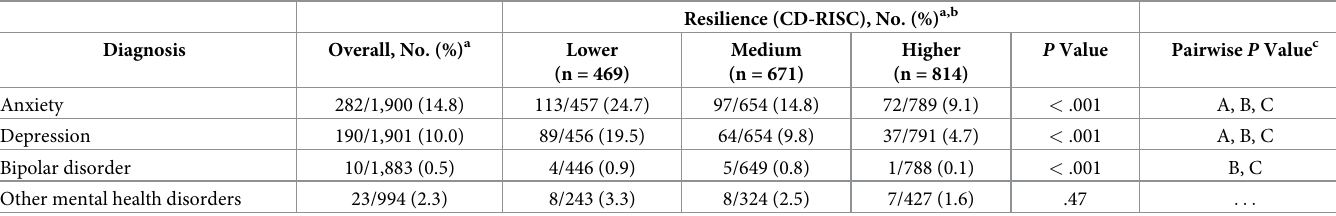
Table 3. Self-reported mental health diagnoses, stratified by resilience